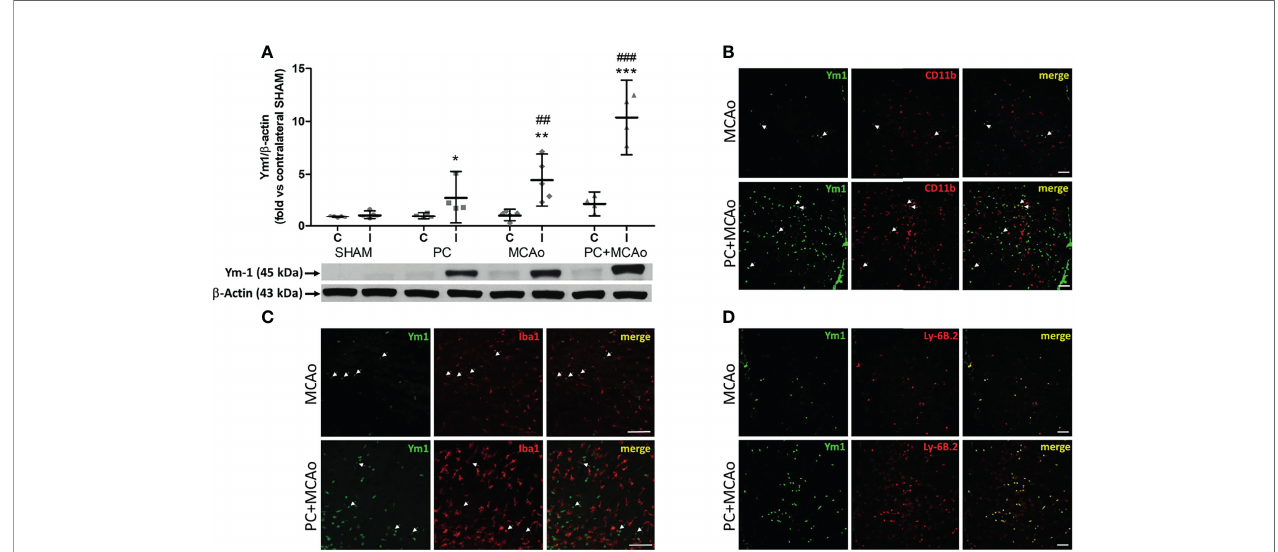
FIGURE 3 | Ischemic PC potentiates the elevation of the M2/N2 marker Ym1 caused by 1h MCAo in myeloid cells of the ischemic cortex of mice. (A) Western blotting analysis of Ym1 expression in tissue homogenates from the contralateral (C) and ipsilateral (ischemic, I) cortex of mice subjected to SHAM surgery, ischemic PC (15 min MCAo followed by 72h of reperfusion), 1h MCAo followed by 24h of reperfusion (MCAo) or PC+MCAo. *P = 0.0479, **P = 0.0079 and ***P = 0.0004 vs corresponding contralateral; ## P = 0.0059 and ### P = 0.0003 vs ipsilateral SHAM (two-way ANOVA followed by Bonferroni post-test, n=4-5 mice per experimental group). Representative immuno fl uoresce images showing Ym1 expression (green fl uorescence) in CD11b immunopositive myeloid cells [red fl uorescence in (B) ], Iba1 immunopositive microglia/macrophages [red fl uorescence in (C) ] or Ly-6B.2 immunopositive myeloid cells [granulocytes and monocytes/macrophages, red